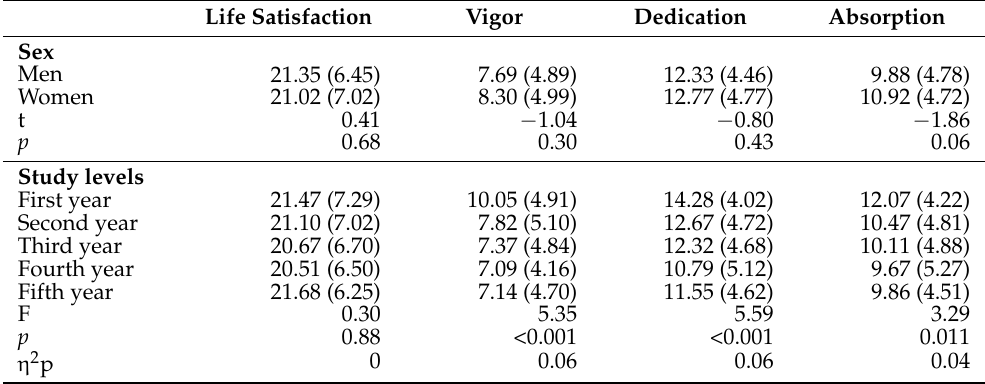
Table 5. Means, Standard Deviations, Student’s t, and ANOVA according to sex and educational